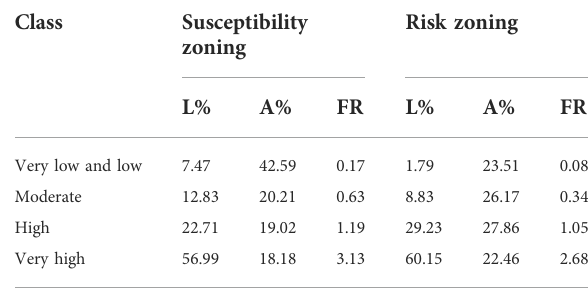
FIGURE 10 Statistical chart of area ratio, landslide ratio and landslide frequency ratio. Where, SLR = susceptibility landslide ratio, RLR = risk landslide ratio, SLFR = susceptibility landslide frequency ratio, RLFR = risk landslide frequency